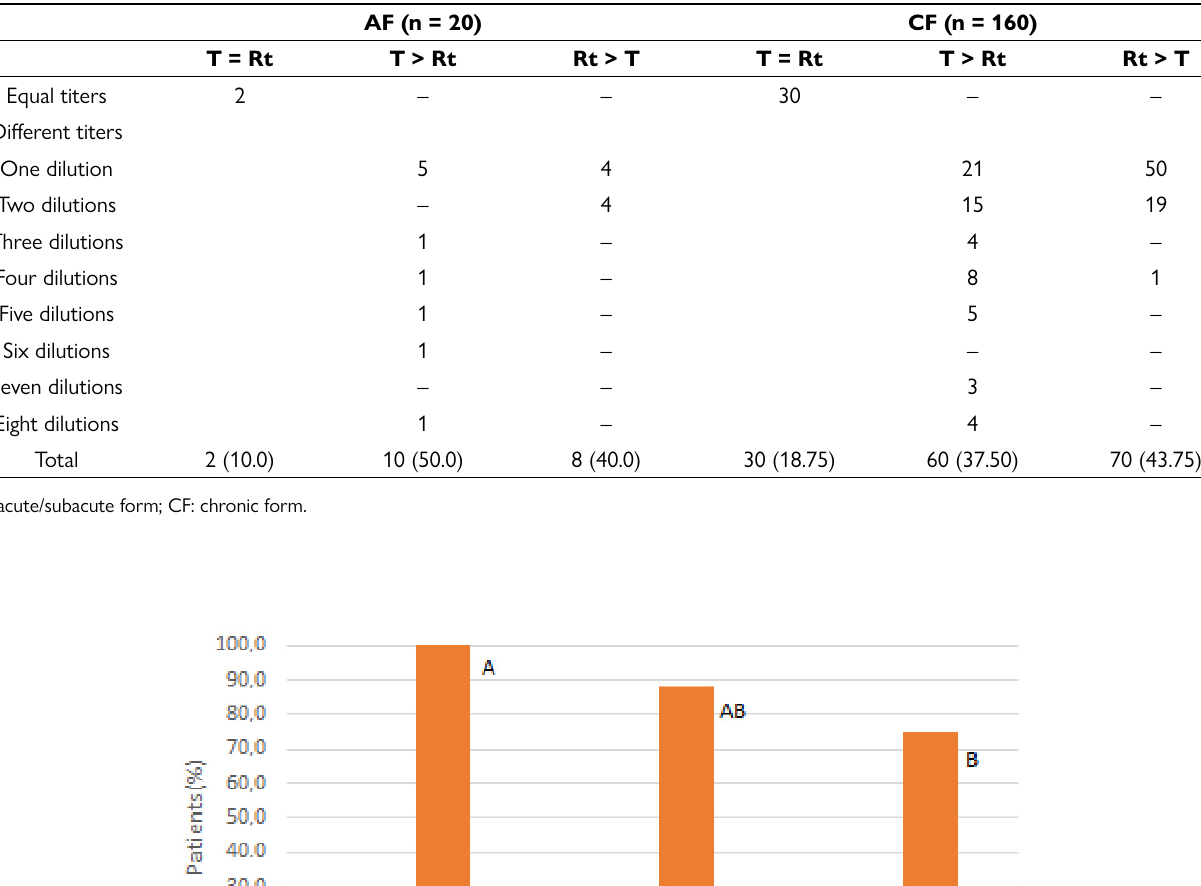
Table 4. Distribution of 20 patients with the acute/subacute form and 160 with the chronic form of paracoccidioidomycosis as to the intensity of the specific antibody serum levels, determined by the double agar gel immunodiffusion test, at the moment of blood draw (test – T) and after at least six months of storage at –80 o C (retest – Rt). Comparisons performed by chi-square test or by Fisher’s exact test.